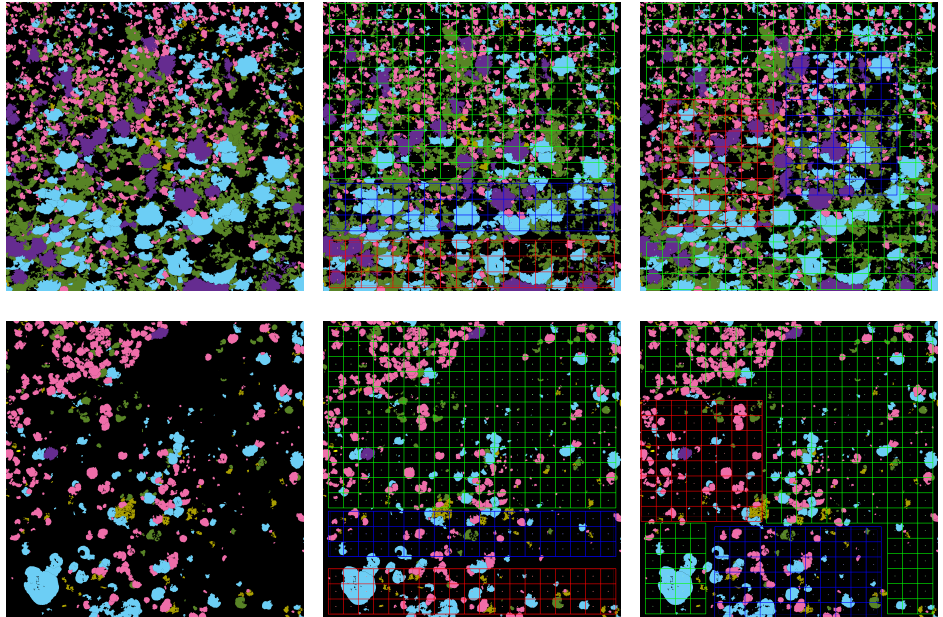
Figure 3. Results of the ecologically inspired partition of the orthos vs a uniform partition. The validation area is colored in blue, the test in red. The small rectangles represents the dataset clipped tiles. The first row is related to the labels of the FLI-1 plot, the second row to the MIL-4 plot. We also compared results obtained by selecting the training/validation areas using the uniform or the ecologically inspired partition, keeping always as test area the red part at the bottom of the map, to favor the consistency of numerical results. Table 2 reports the accuracy and mIoU of the two